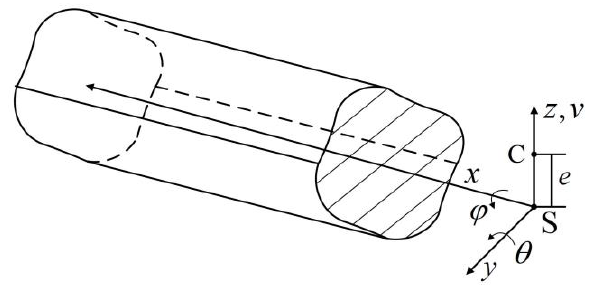
7 of 21 Figure 5. Shapes of ( a ) wave 1 at 140 Hz, ( b ) wave 2 at 5000 Hz, ( c ) wave 3 at 140 Hz, ( d ) wave 4 at 5000 Hz, ( e ) wave 6 at 5000 Hz, ( f ) Wave 5 at 1200 Hz, ( g ) wave 7 at 5000 Hz. Table 1. Three wave motions in Figure 5. Wave Motion Wave Flexural 1 (140 Hz), 2 (5000 Hz) Flexural-torsional coupled